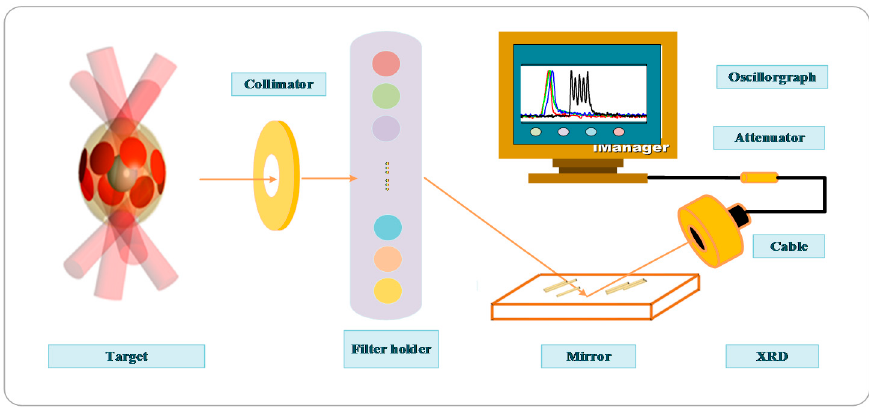
Figure 2. Soft X-ray spectrometer layout.